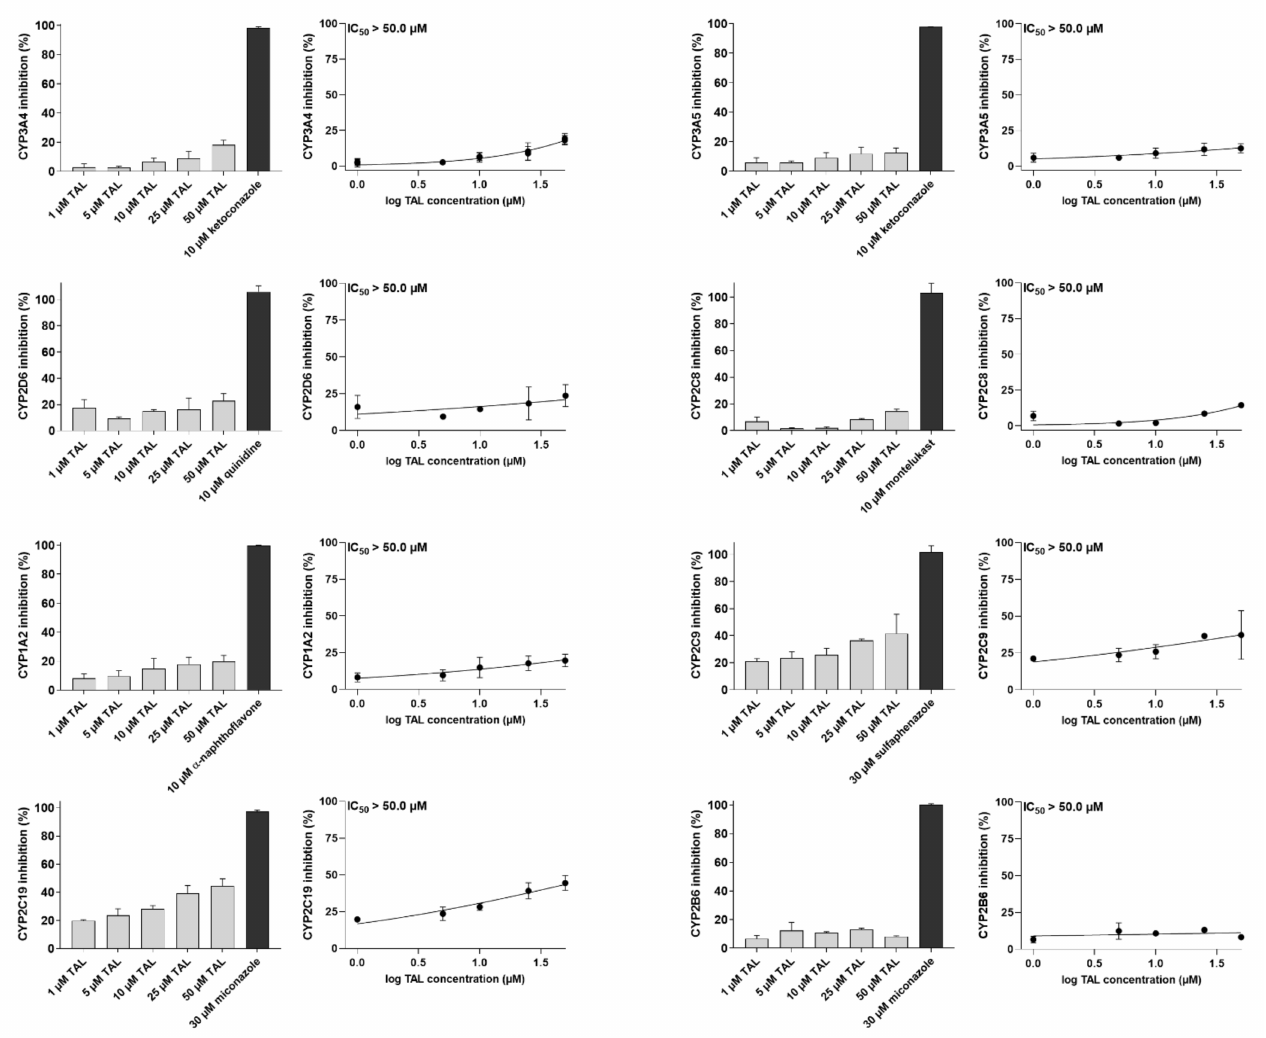
Figure 5. Incubation assays with recombinant CYP1A2, CYP2B6, CYP2C8, CYP2C9, CYP2C19, CYP2D6, CYP3A4, and CYP3A5. The enzymes were pre-exposed to talazoparib or model inhibitors, which was followed by the initiation of reaction using the mixture of NADP + and particular Vivid substrate. After incubation, fluorescence was measured and then normalized against 0% and 100% activity values. Control 100% activity values were represented by the reaction, which included the enzyme and 0.5% DMSO without tested drug. The control 0% activity values came from the samples that contained only 0.5% DMSO and enzyme solvent buffer without enzyme. IC 50 values were defined with the normalized fluorescence data. The data come from three independent repetitions and are expressed as means ± SD. TAL,